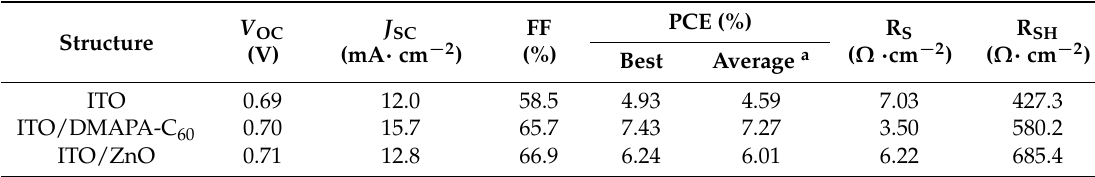
Figure 3. ( a ) J - V curves, ( b ) EQE curves and, ( c ) Dark J-V curves of OSCs based on different CBLs. Table 2. Device performances of OSCs based on different CBLs.